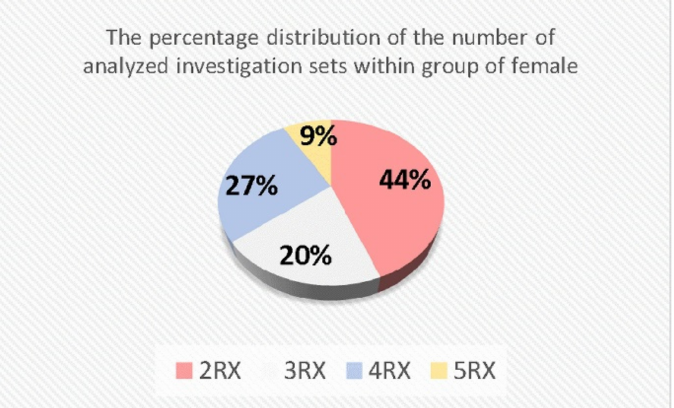
Figure 1. The percentage distribution of the number of analyzed investigation sets within the group of females. Out of the 59 sets of investigations, 44% had 2 sets of investigations done, 20% had 3 sets, 27% had 4 sets, and 9% had 5 sets (in the diagram 2RX, 3RX, 4RX, and 5RX represents the number of sets of radiological investigations).